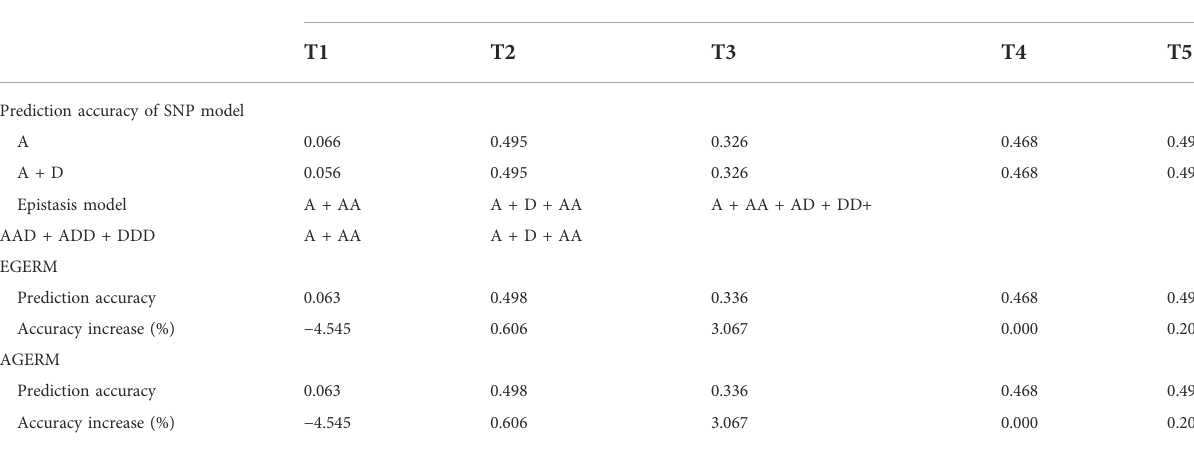
TABLE 2 Observed prediction accuracy of epistasis models relative to the additive model for fi ve traits in a swine